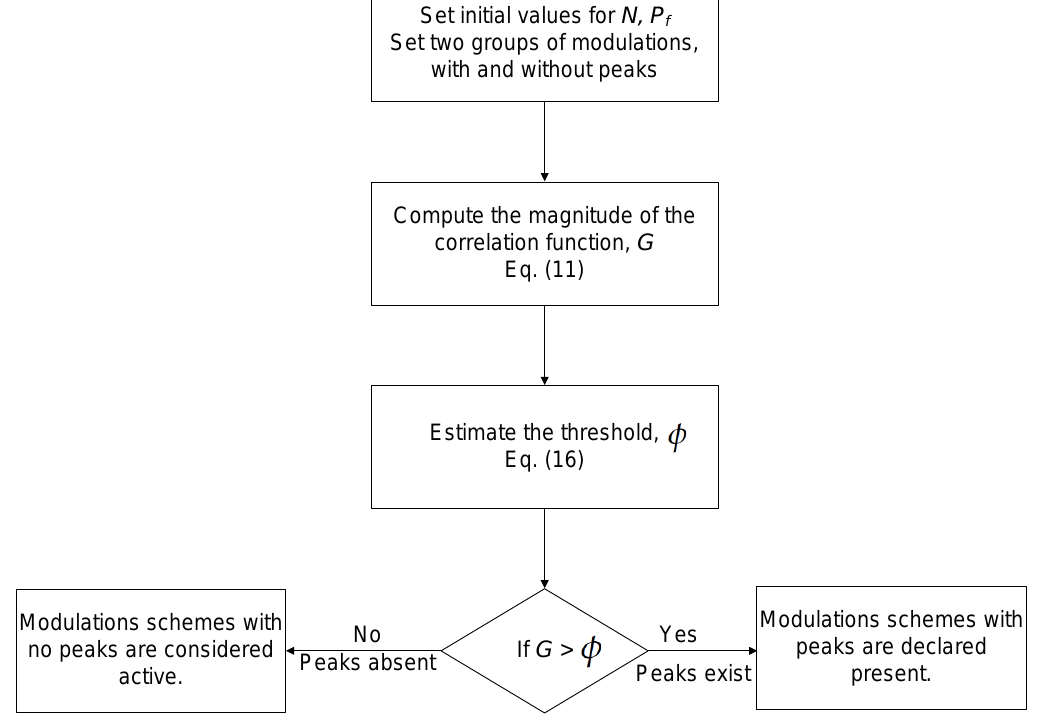
Figure 6. A summary of the proposed peak